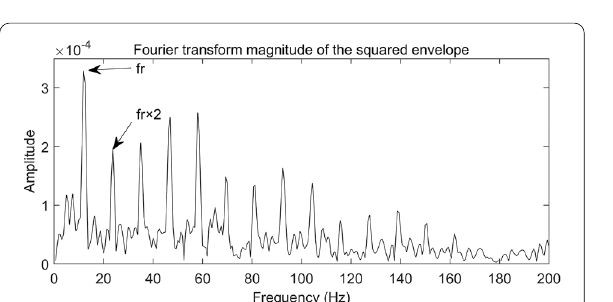
Figure 32 The squared envelope spectrum of the processed signal based on KM